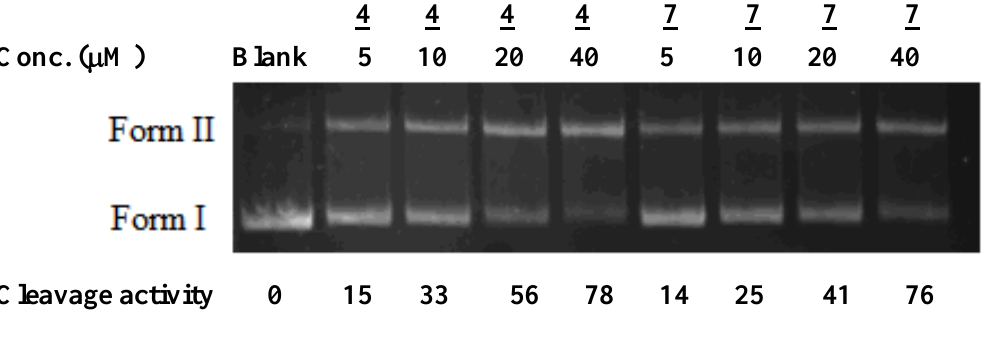
Figure 2. DNA photocleavage activity of porphyrin 4 (lanes 2-5) and porphyrin 7 (lanes 6-9) as a function of its concentration. Lane 1: DNA (Form I) control; lane 2, 6: 5 μ M;